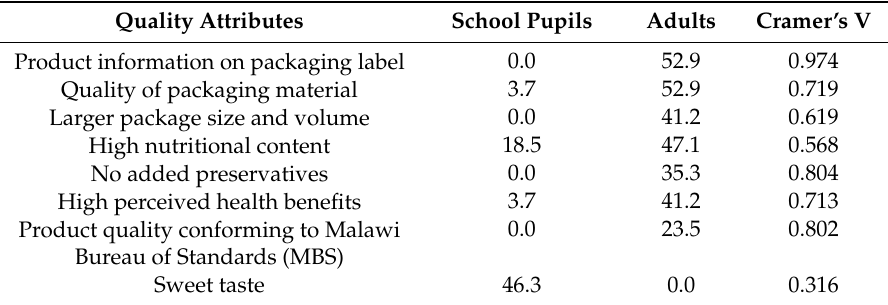
Table 3. Quality attributes preferred by baobab juice consumers (% strong agreement).